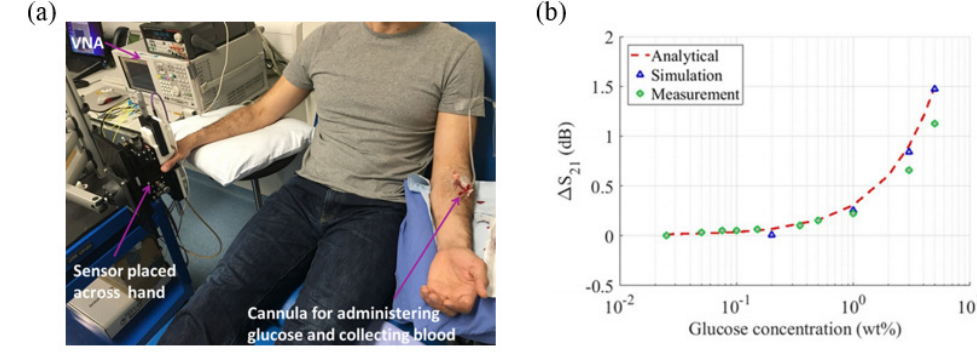
Figure 11. Glucose concentration detection using a 60 GHz microstrip patch antenna. ( a ) Experimen- tal setup for a real-time in vivo human clinical test. ( b ) Variation in the transmission coefficient of the sensor as a function of the glucose concentration